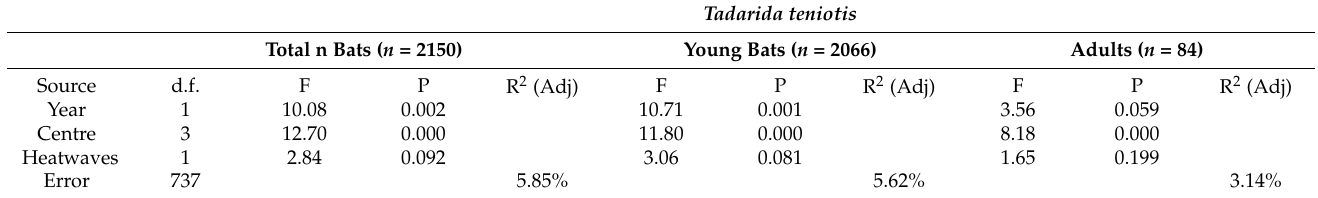
Table 4. Results of a GLM ANCOVA on Tadarida teniotis admitted at four Italian rehabilitation centres in 2007–2021. Temperature = weekly mean of maximum temperatures